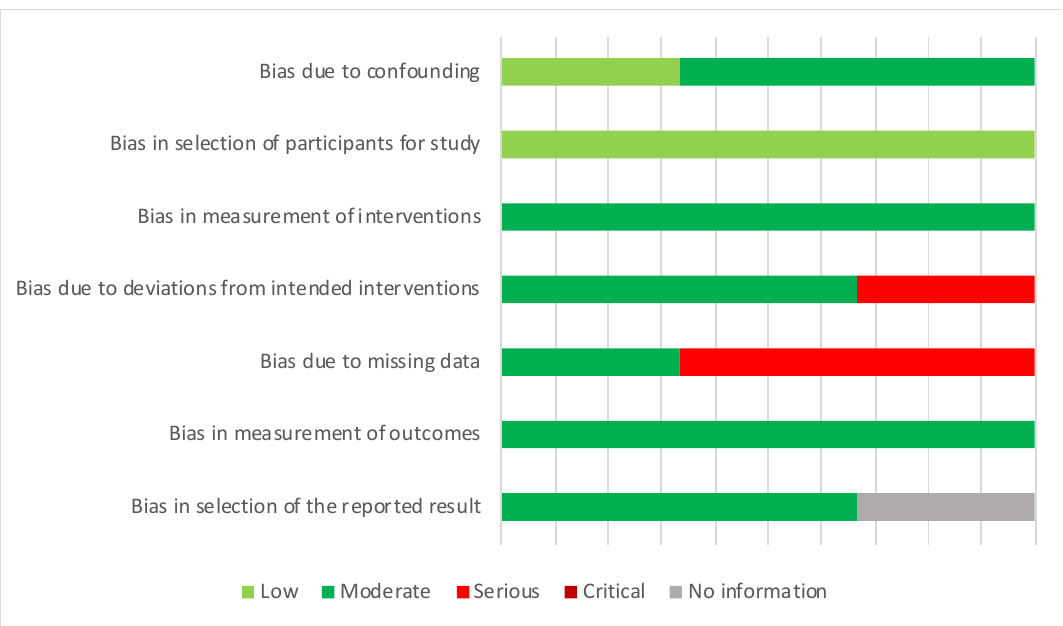
Figure A1. Risk of bias for randomized controlled trials (RCTs) using the Cochrane Collaboration’s tool for assessing the risk of bias (RoB2). Nutrients 2020 , 12 , x FOR PEER REVIEW